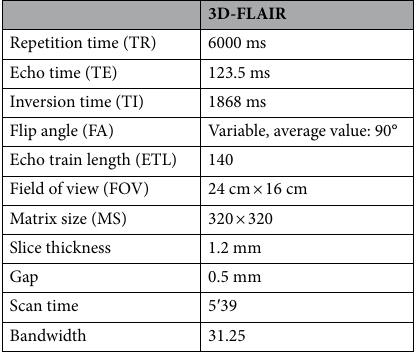
Table 1. Parameters of magnetic resonance imaging scan.